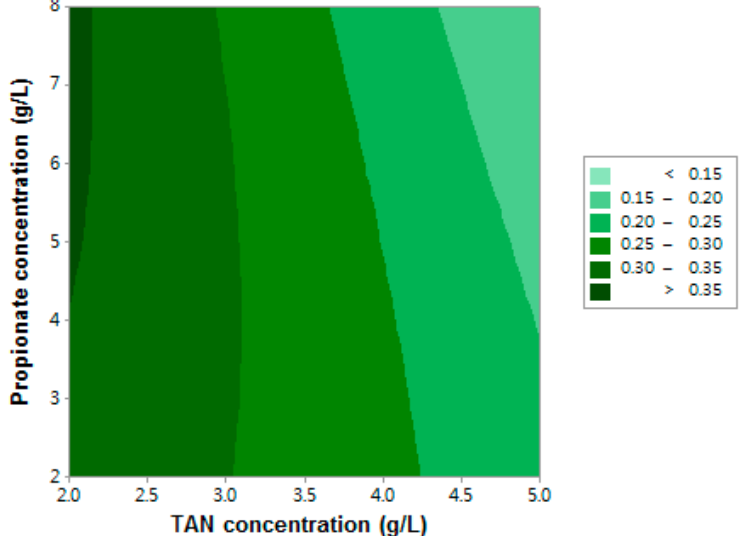
Figure 3. Two-dimensional contour plot of the methane yield within the experimental design.